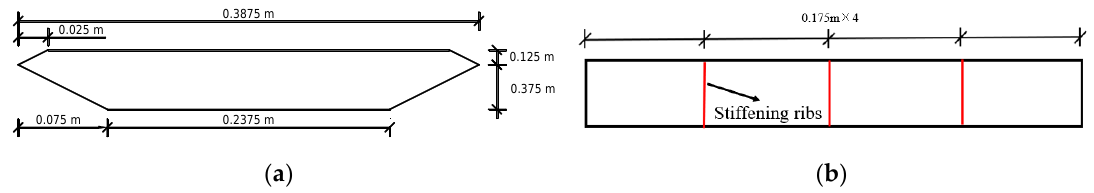
Figure 1. Size of the section model: ( a ) cross section; ( b ) longitudinal section.